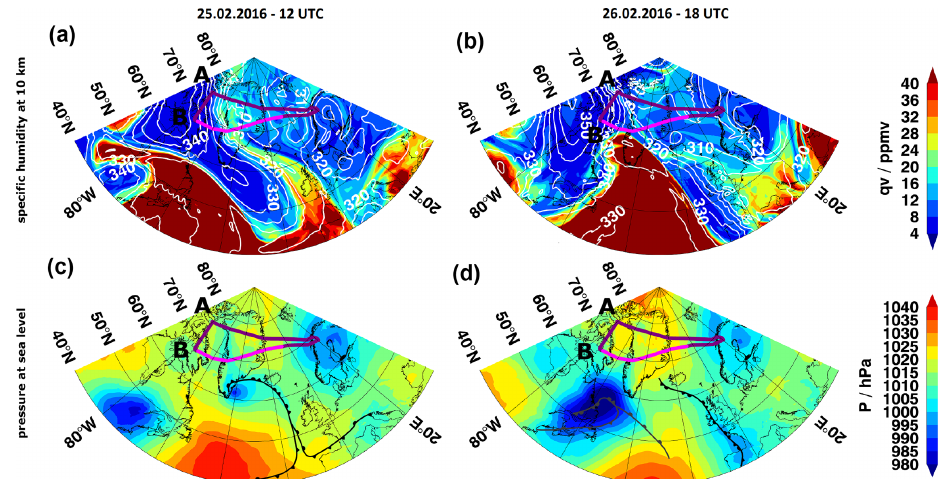
Figure 4. Meteorological conditions in the tropopause region and at sea level on 25 February 2016 (a, c) and the flight day, 26 Febru- ary 2016 (b, d) , as modelled by ICON-ART. Specific humidity is shown by colour contours, and potential temperature is shown as white contour lines at 10km altitude (a, b) . Pressure at sea level is shown with selected warm fronts, cold fronts and occlusions (black and dark- grey overlays) (c, d) . The HALO flight track on flight day is indicated by a purple line. The section of the flight that covers the filaments observed by GLORIA and analysed in the model data in Sect. 4.2 and 4.3 is highlighted in magenta in all